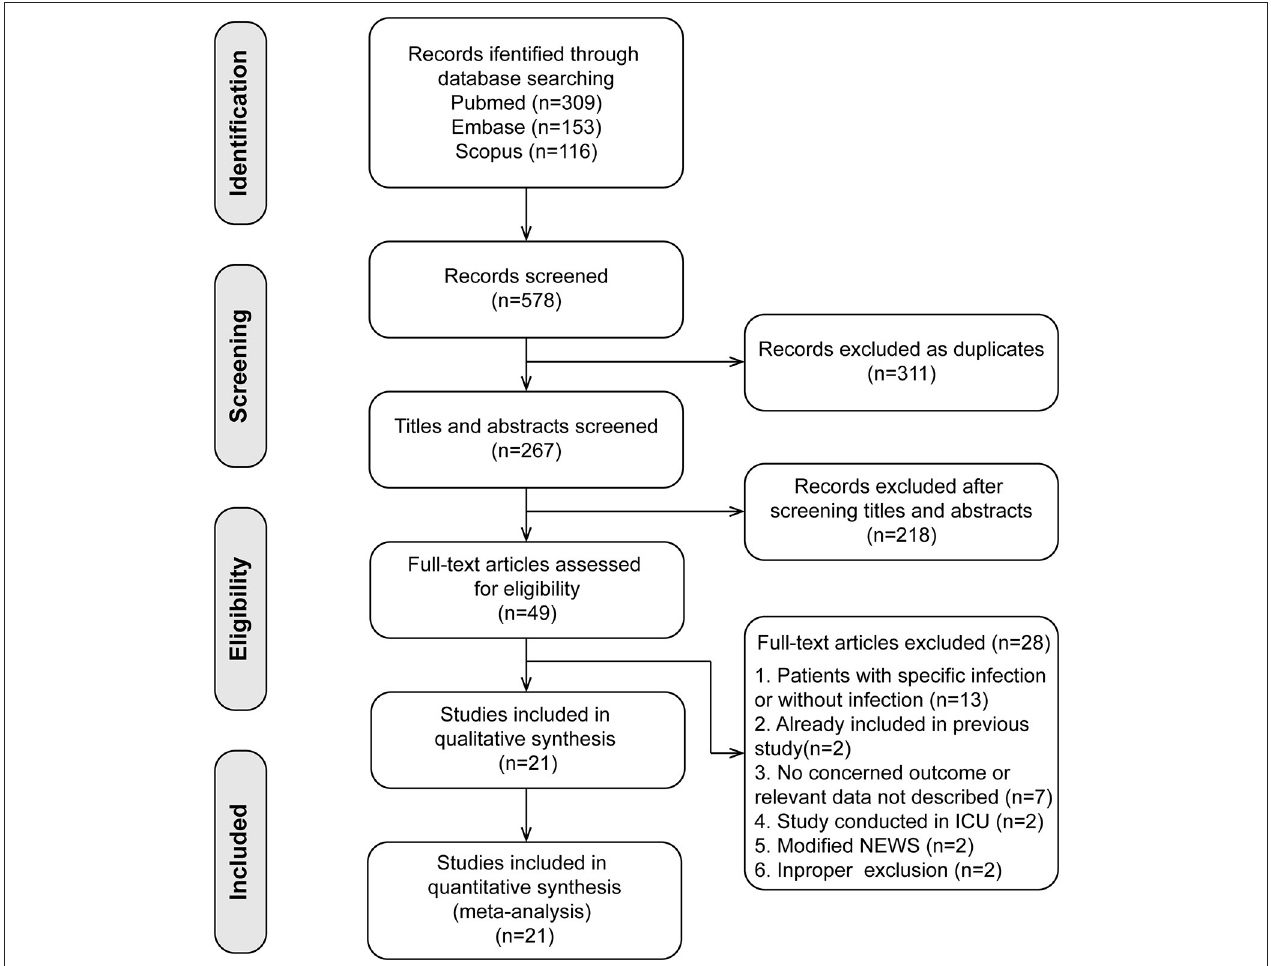
FIGURE 1 | Flow diagram of study